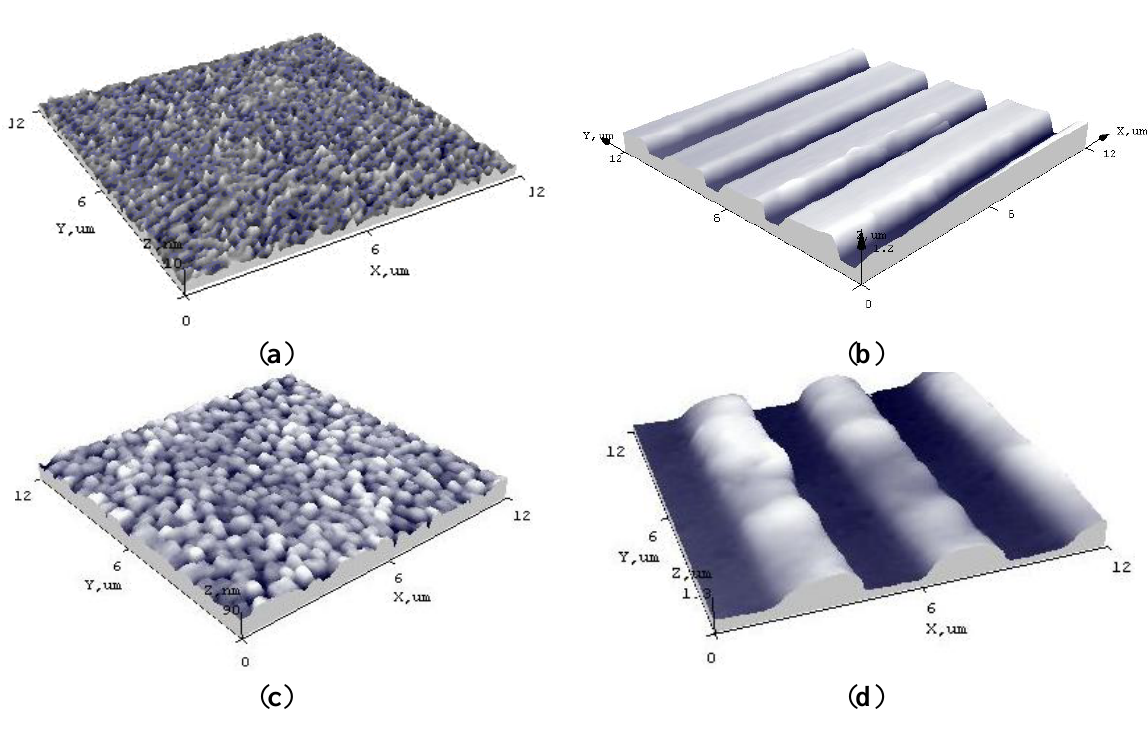
Figure 3. 3D views of ( a ) PVDF-PMMA-Ag thin film and ( b ) grating on it; ( c ) PVDF-PMMA-BaTiO -Ag thin film and ( d ) grating on it. 3